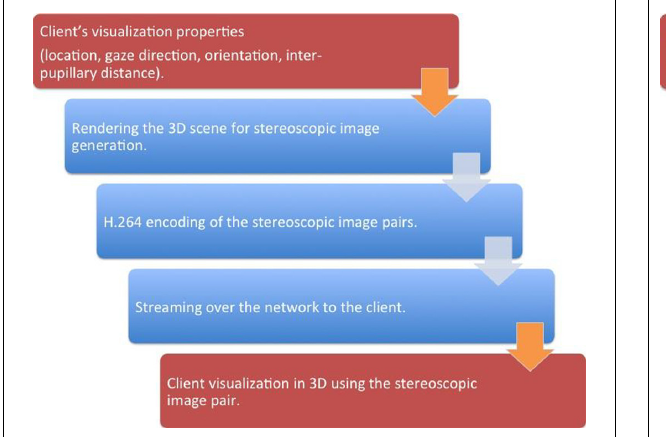
FIGURE 3 |A schematic representation of the client–server interfaces. The steps that occur on the client is represented by red while the steps that occur on the server side is represented by blue.The brown arrows represent the client–server network interface.